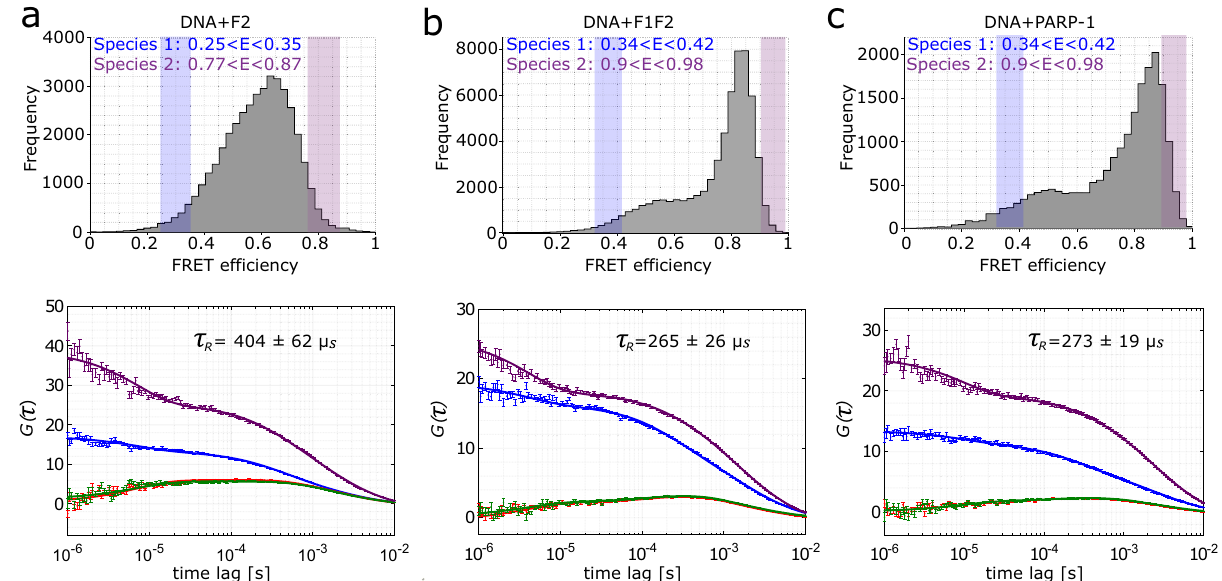
Fig. 5 | Results of fFCS analysis for DNA in presence of F2, F1F2 and full length PARP-1. Dynamic analysis using fFCS for DNA in presence of F2 ( a ), in presence of F1F2 ( b ) and in presence of full-length PARP-1 ( c ). FRET ef fi ciency histograms (the sameasinFig.2)withthethresholdsthatde fi nespecies1(shadedblueregion)and species 2 (shaded violet region) are shown in the upper panels and the